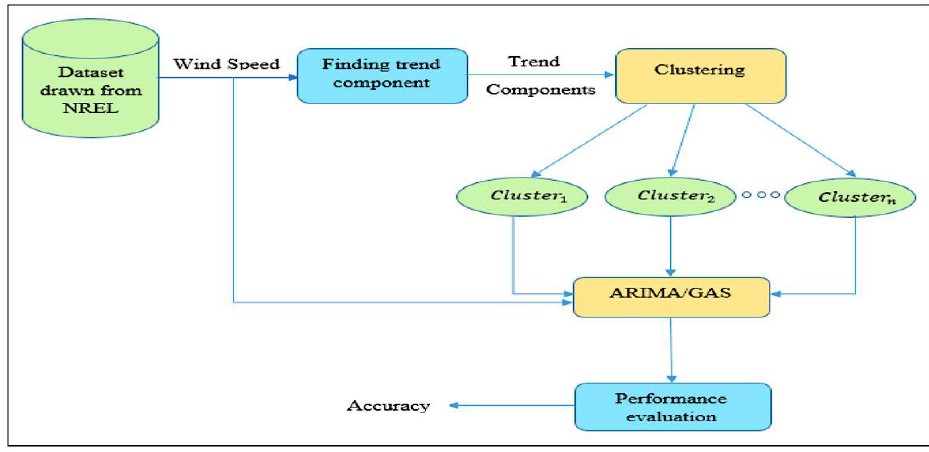
Figure 24. Proposed model for wind speed prediction [21].